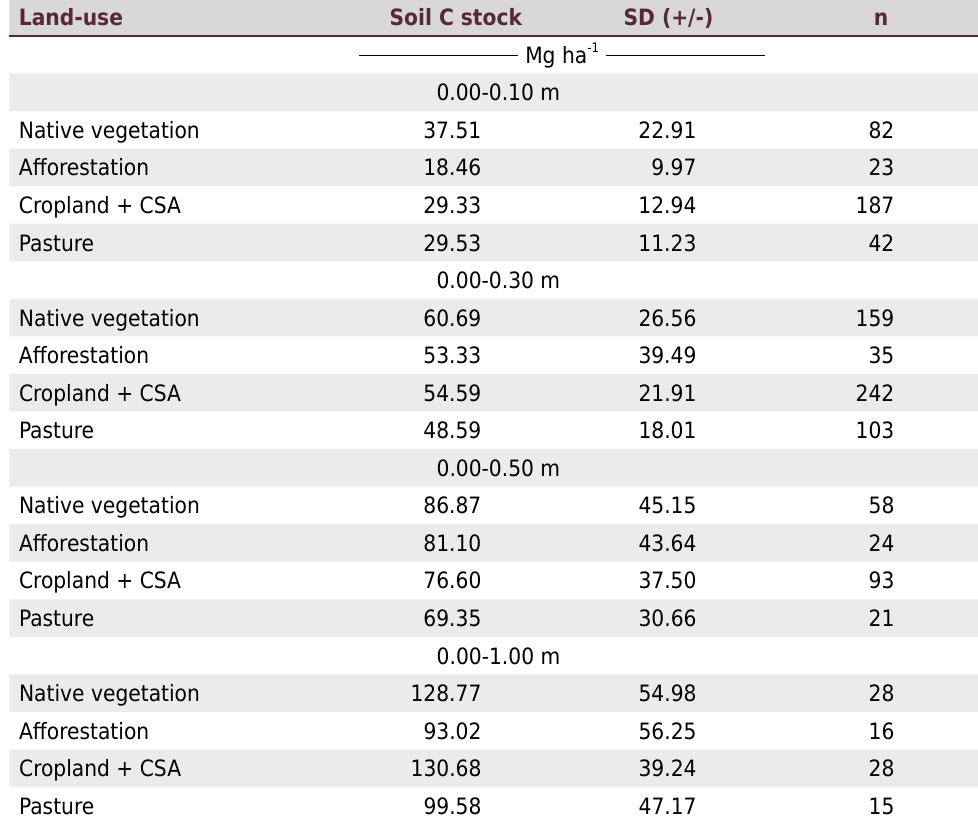
Table 1. Carbon stocks at the 0.00–0.10, 0.00–0.30, 0.00–0.50 and 0.00–1.00 m soil layers in the main land uses of Brazilian